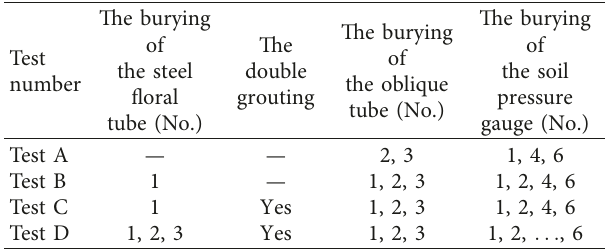
Table 1: Experimental test